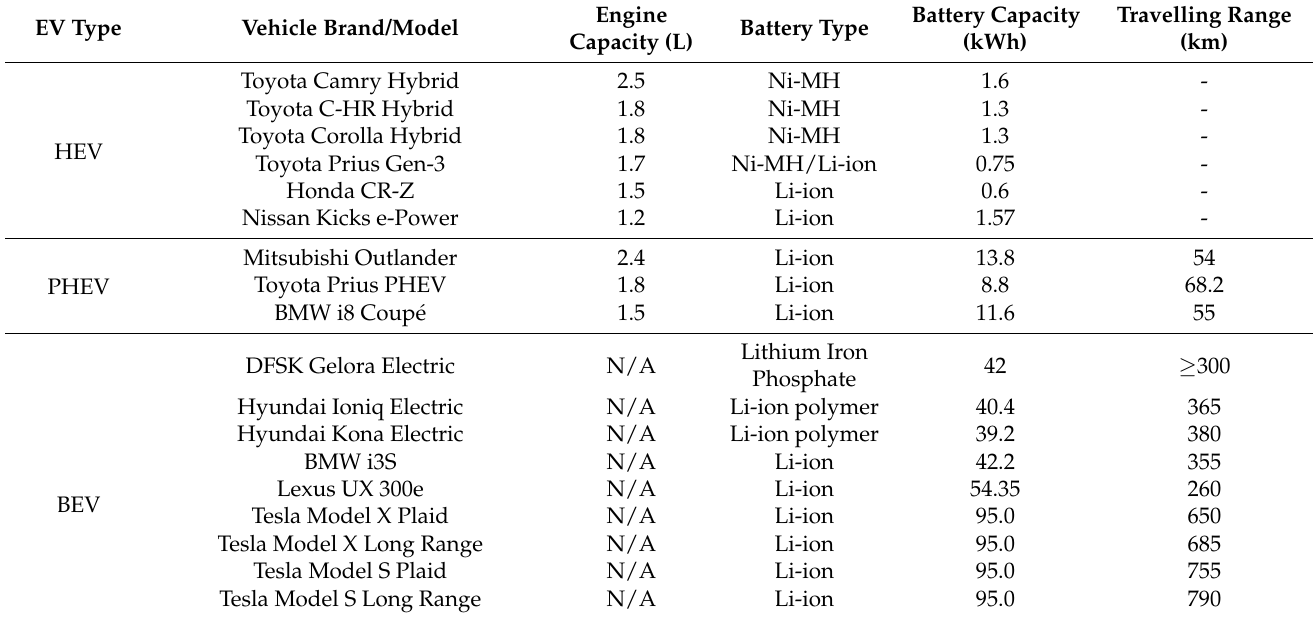
Table 2. Available EVs in Indonesian